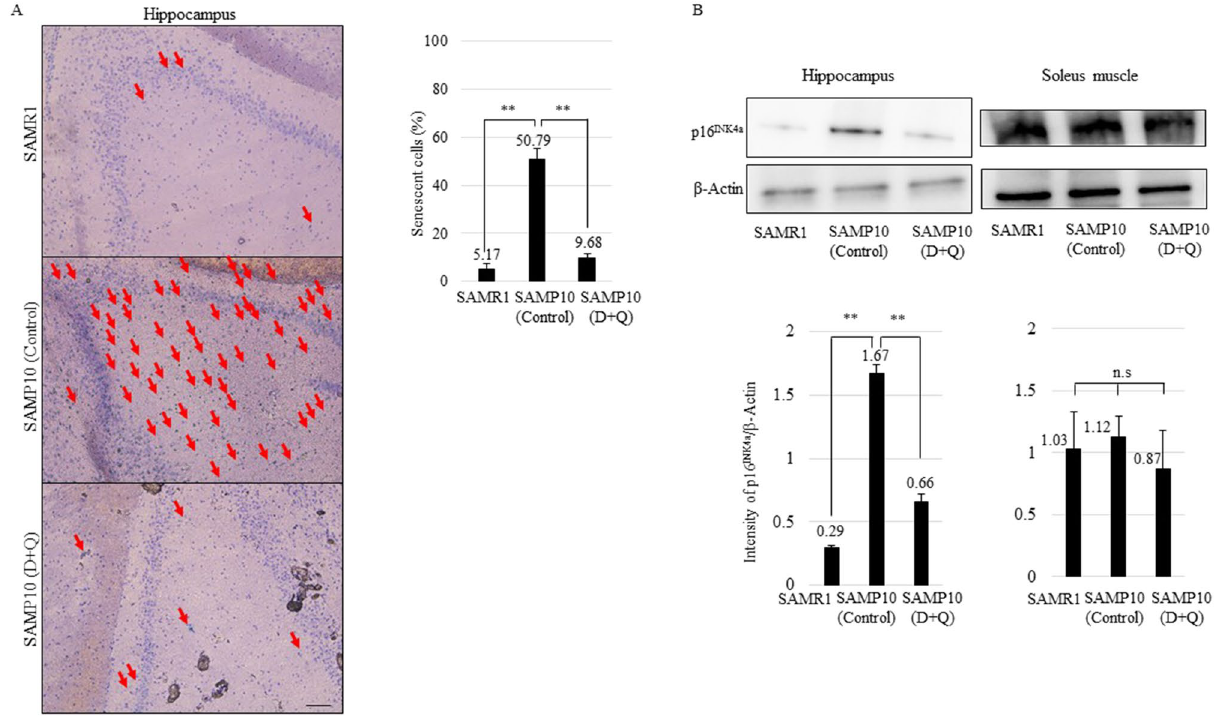
Figure 2. ( A ) Photographs of SABG and hematoxylin staining in SAMR1 and SAMP10 at 38 weeks of age (control and D + Q (5 mg/kg + 50 mg/kg)) hippocampus. Red arrows indicate SABG-positive cells. Right panel shows percentage (%) of SABG-positive cells in hippocampus (n = 3). ( B) Immunoblotting of hippocampus of SAMR1, control vehicle ( C ) and D + Q-treated (D + Q) SAMP10 using p16 Ink4a and β-actin antibody. Intensity of p16 Ink4a expression was normalized by β-actin (n = 3). Cropped blots were used in this figure. Original full- length blots are presented in Supplementary Fig. 2. The display of cropped gels was arranged by ChemiDoc image Lab software (Bio-Rad Laboratories). Mean ± SD, ** p < 0.01, * p < 0.05, Two-tailed Student’s t-test. Scale bar, 100 μm. SABG; senescence-associated beta-galactosidase, D; dasatinib, Q;